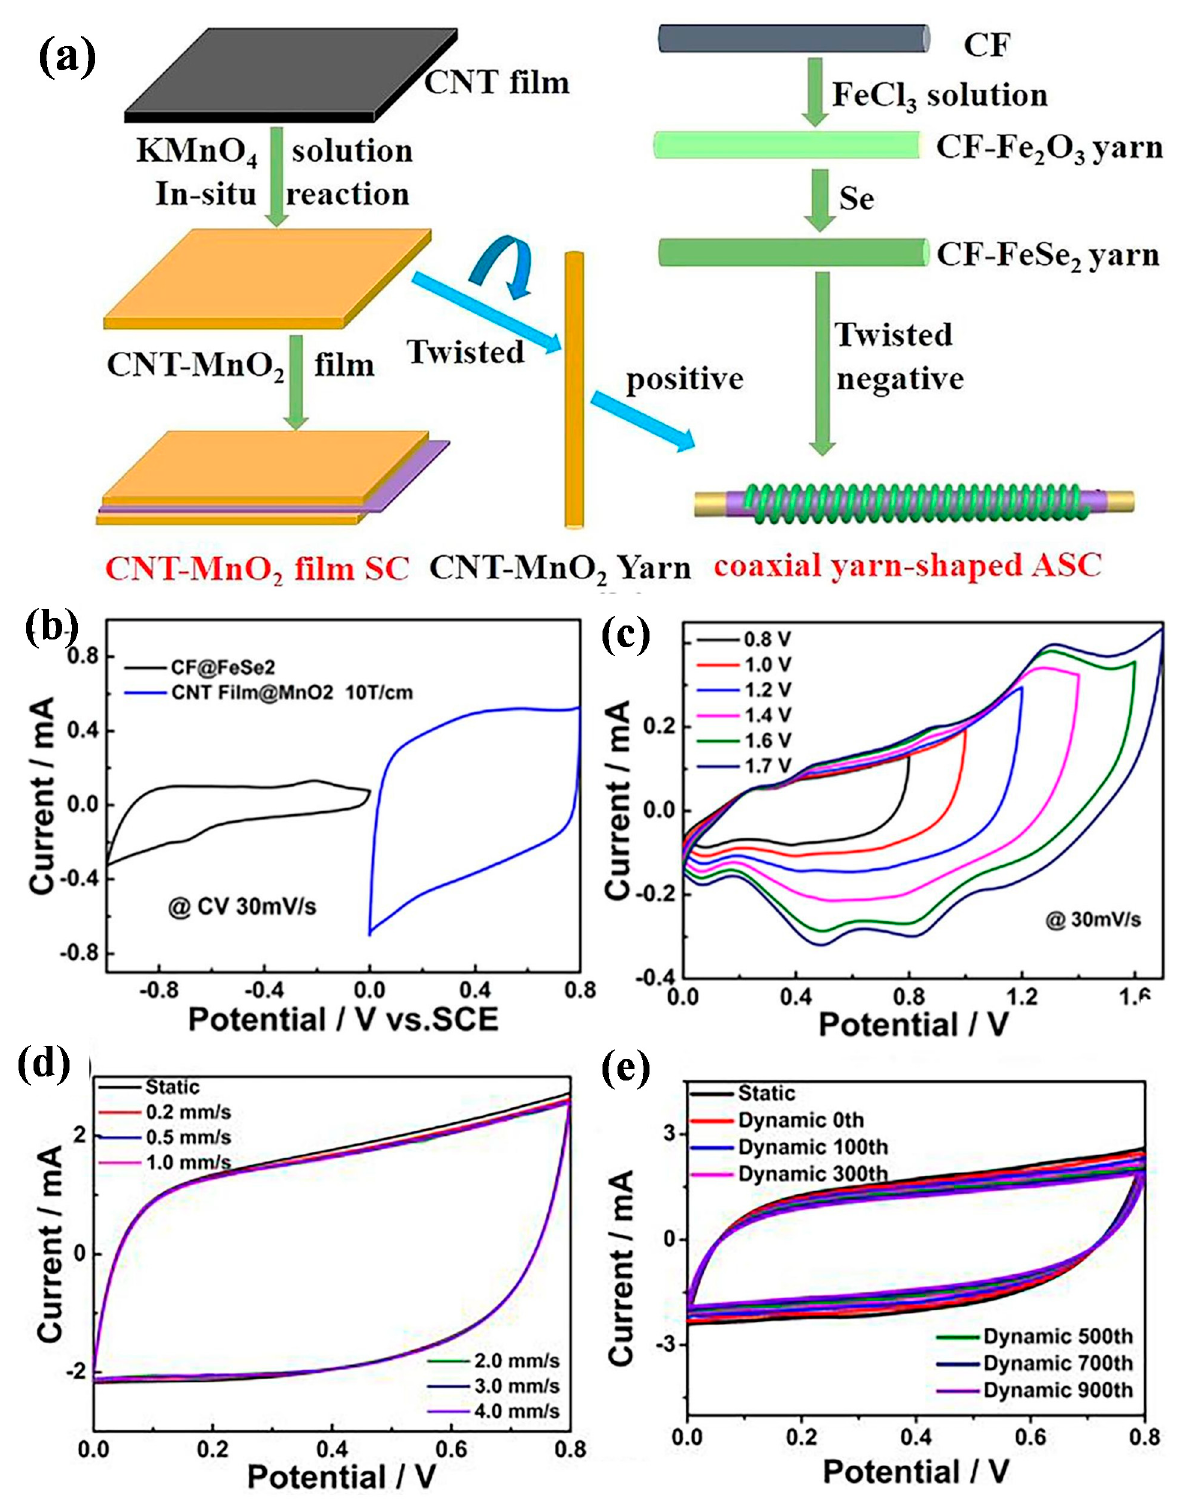
Figure 7. ( a ) Fabrication of CNT-MnO 2 film reconfigurable supercapacitors and coaxial yarn asym- metric supercapacitor, ( b ) CV curves of MnO 2 and FeSe 2 electrodes at 30 mV s − 1 , ( c ) CV curves of MnO 2 //FeSe 2 ASC at 30 mV s − 1 for different voltage windows up to 1.7 V, ( d ) CV curves of symmetric SC at scan rate of 30 mV s − 1 with different dynamic speeds, ( e ) CV curves under different dynamic cycles with a speed of 3 mm s − 1 . Reproduced from Ref. [168]. Copyrights (Elsevier, 2019).